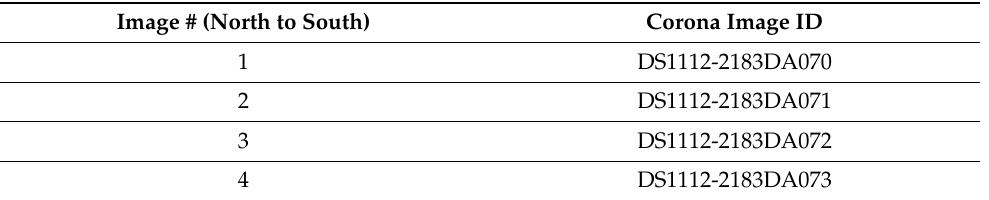
Table 1. Image identifiers for the four Corona images utilized in this study for central Naiman Banner, Inner Mongolia. Image No. 1–4 refers to our internal numbering scheme for the individual strips; Corona Image ID is the metadata label obtained from the source. Image # (North to